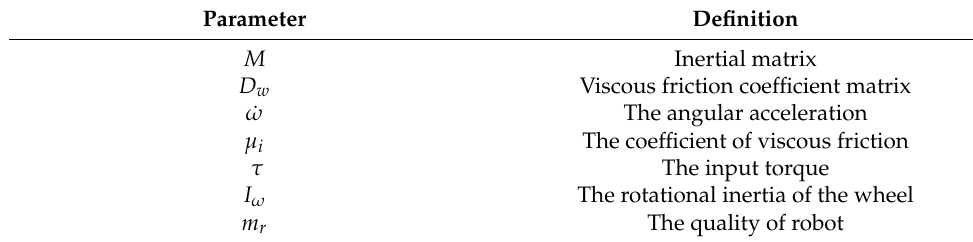
Table 1. Definition of